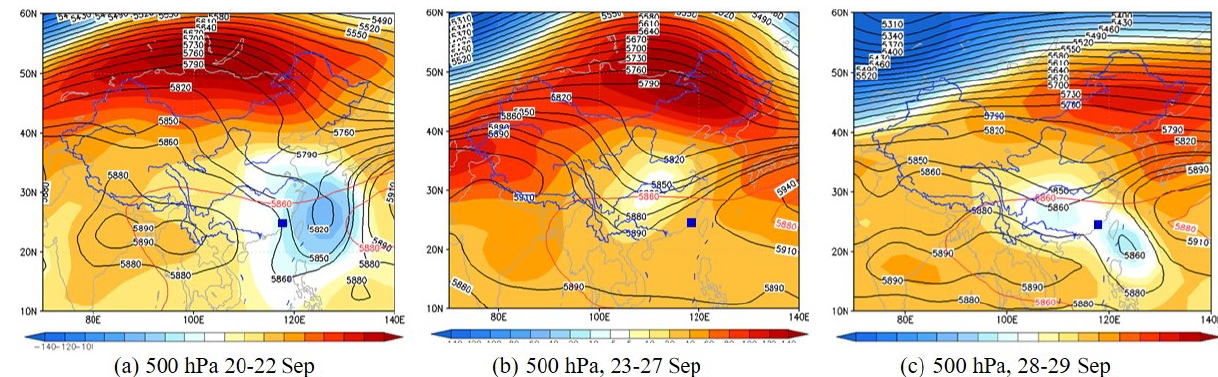
Figure 12. Synoptic situations of continental high pressure from 20 to 29 September 2019. The gradient color area indicates the WPSH over the map, and the contour line is from the characteristic isoline of 5880gpm to the center isoline of 5920gpm. The blue square is the study site.